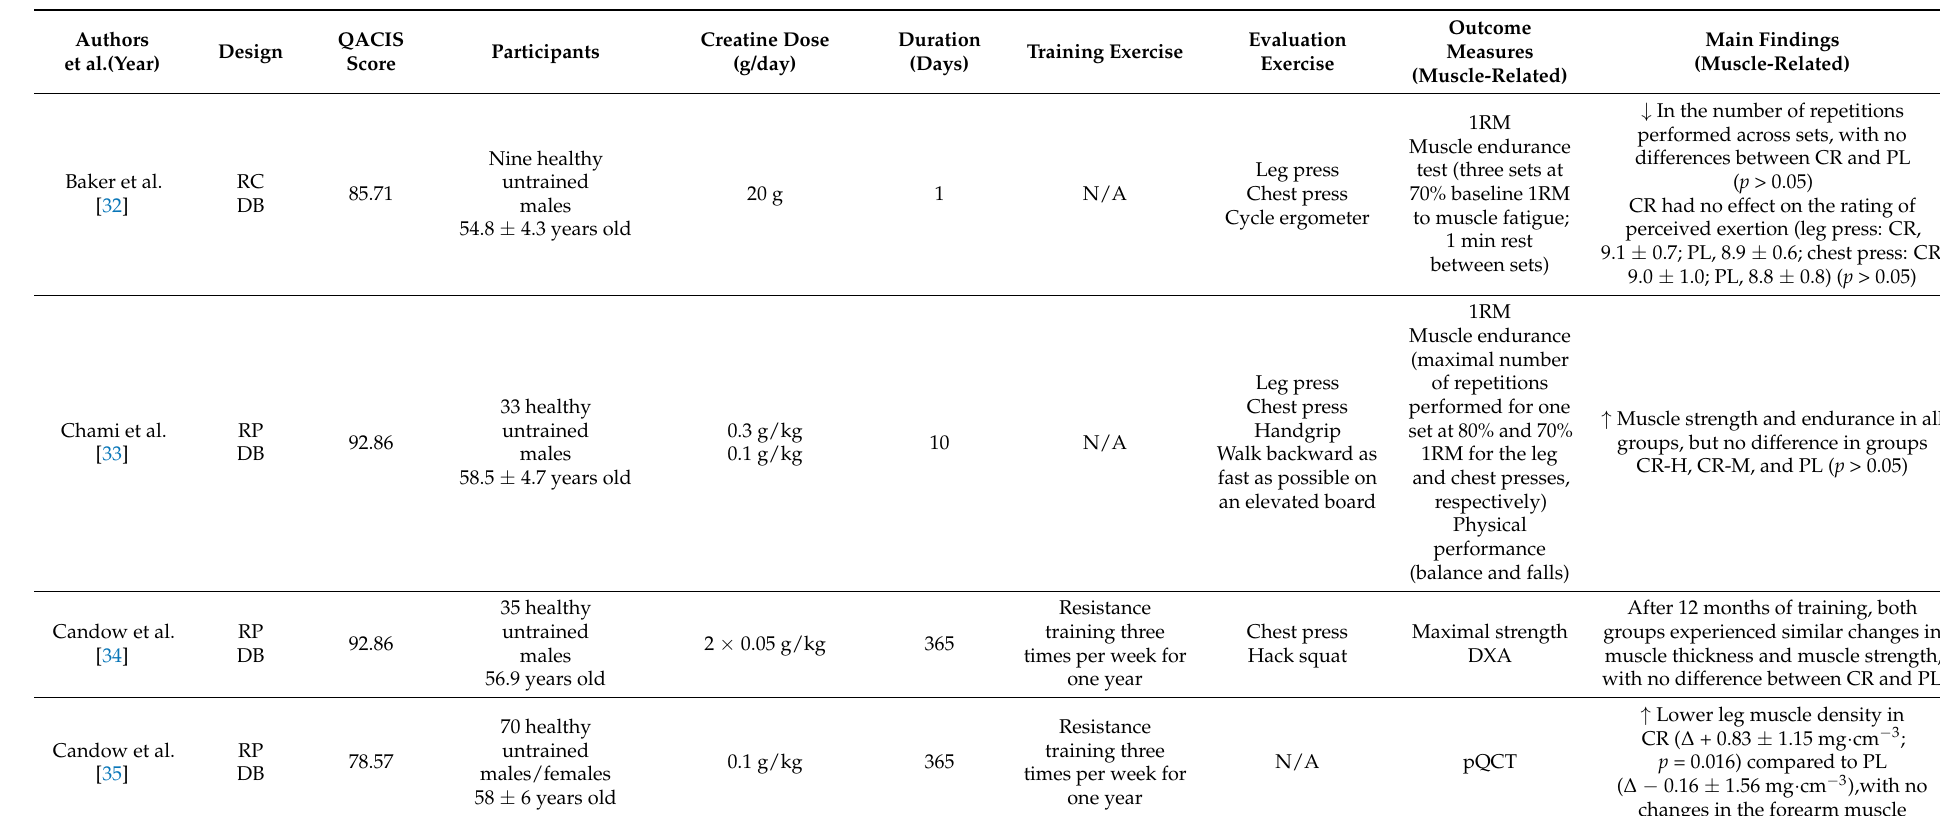
Table 4. Studies recruiting healthy untrained old subjects (to be